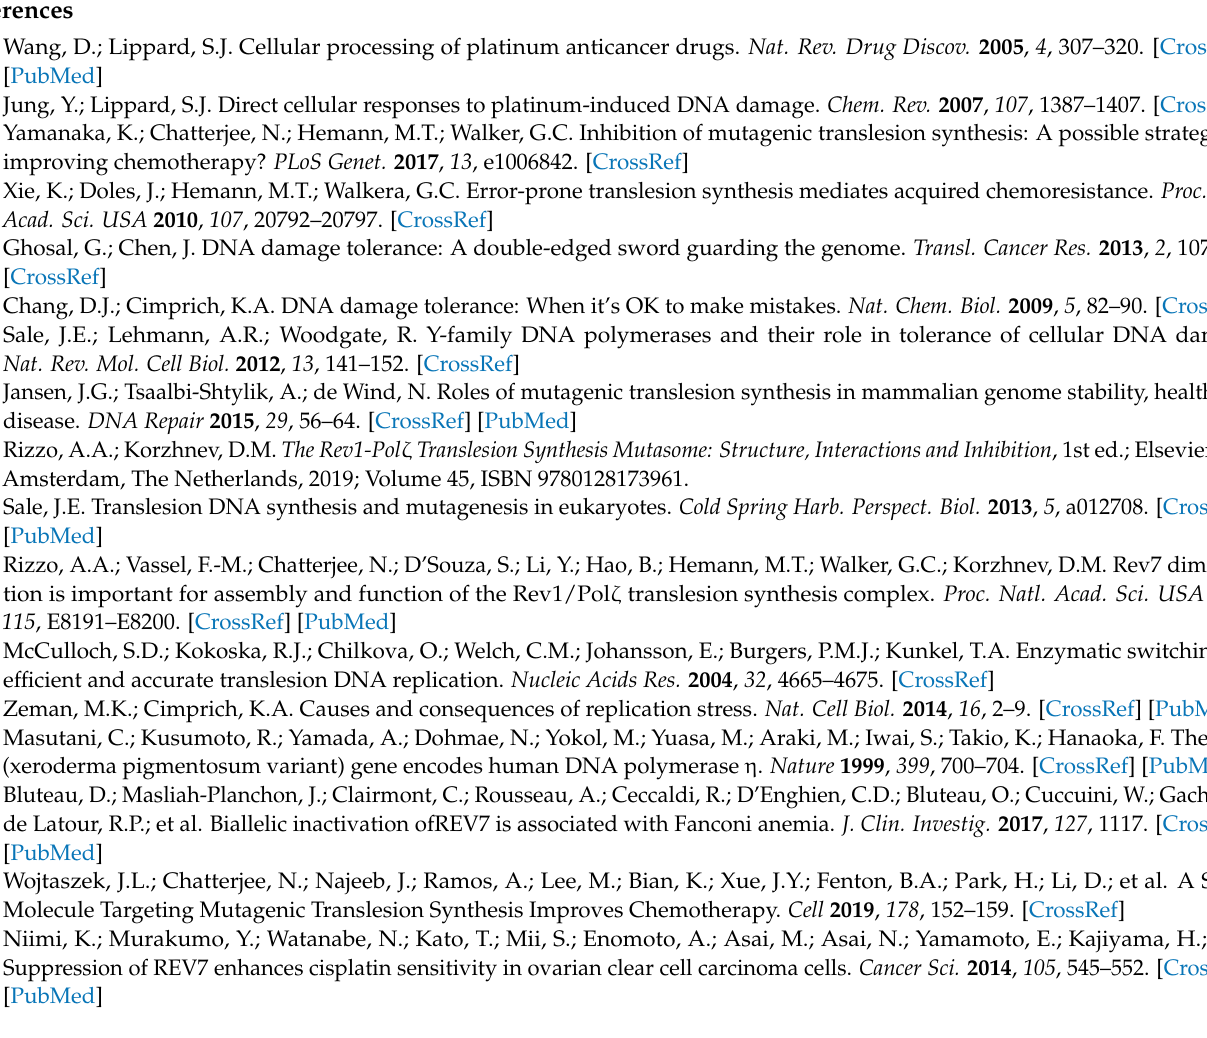
survival assay. Figure S2: Compounds #2 and #3 reduce Rev1-MAD2L2 interaction. (A) Additional blots that have been included in the CETSA quantification in Figure 4C. (B) Additional co-IP blots that have been included in the quantification in Figure